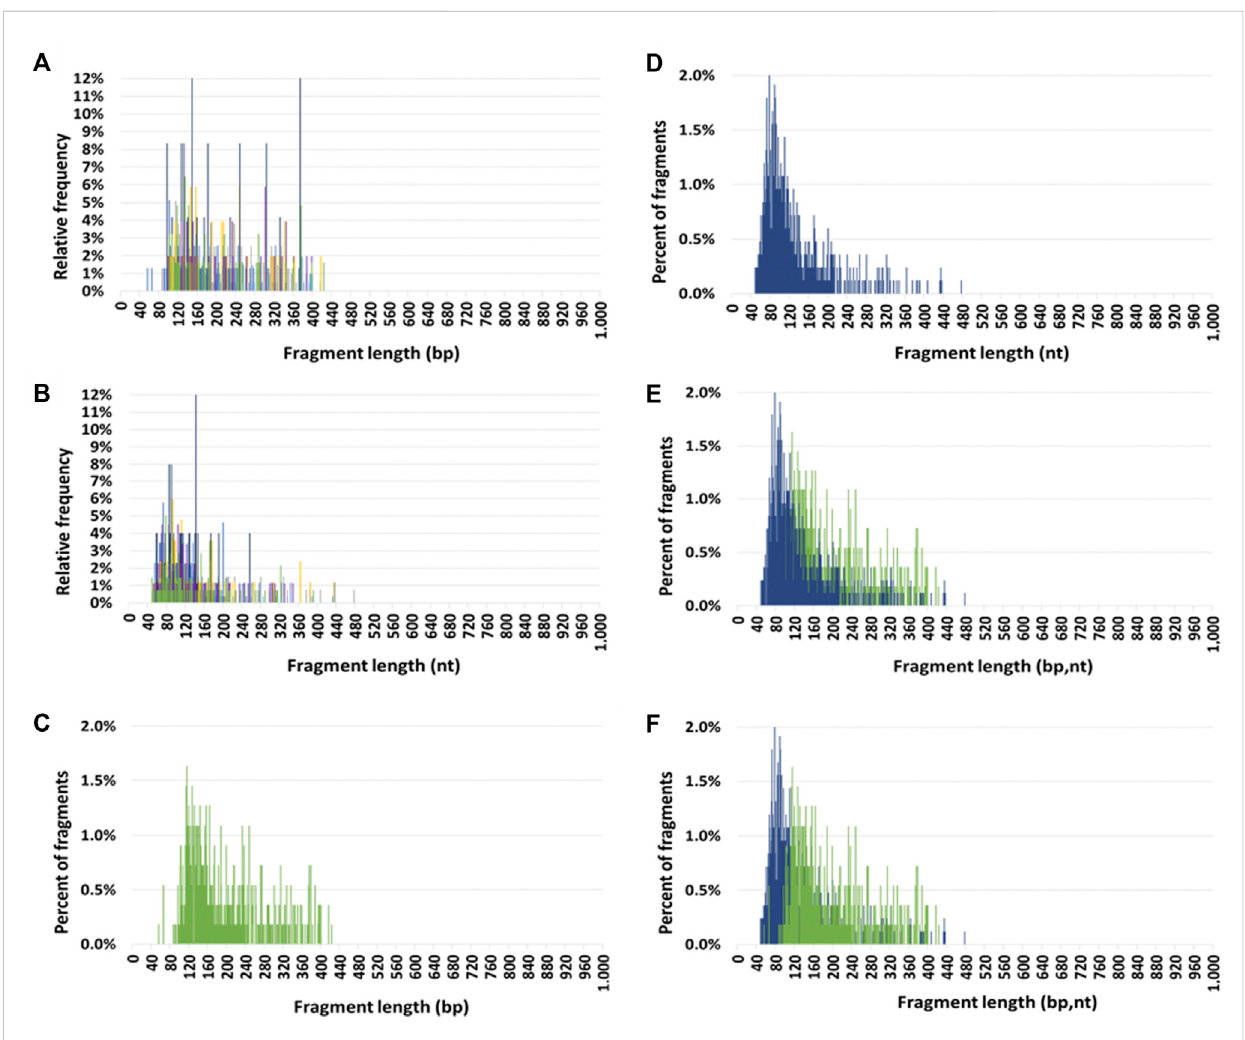
FIGURE 1 Circulating mitochondrial DNA (cir-mtDNA) size pro fi le in healthy individuals. Relative frequencies of cir-mtDNA fragments from seven subjects (seven colours) as determined by low-pass WGS: (A) , DSP sequencing (DSP-S); (B) , SSP sequencing (SSP-S). Mean percent of fragments of cir-mtDNA fromthesevensubjectsasdeterminedbyDSP-S[green, (C,E,F) ]andSSP-S[blue, (D,E,F) ]:DSP-Salone (C) ,SSP-Salone (D) ,SSP-SinforegroundandDSP- S in background (E) , DSP-S in foreground and SSP-S in background (F)